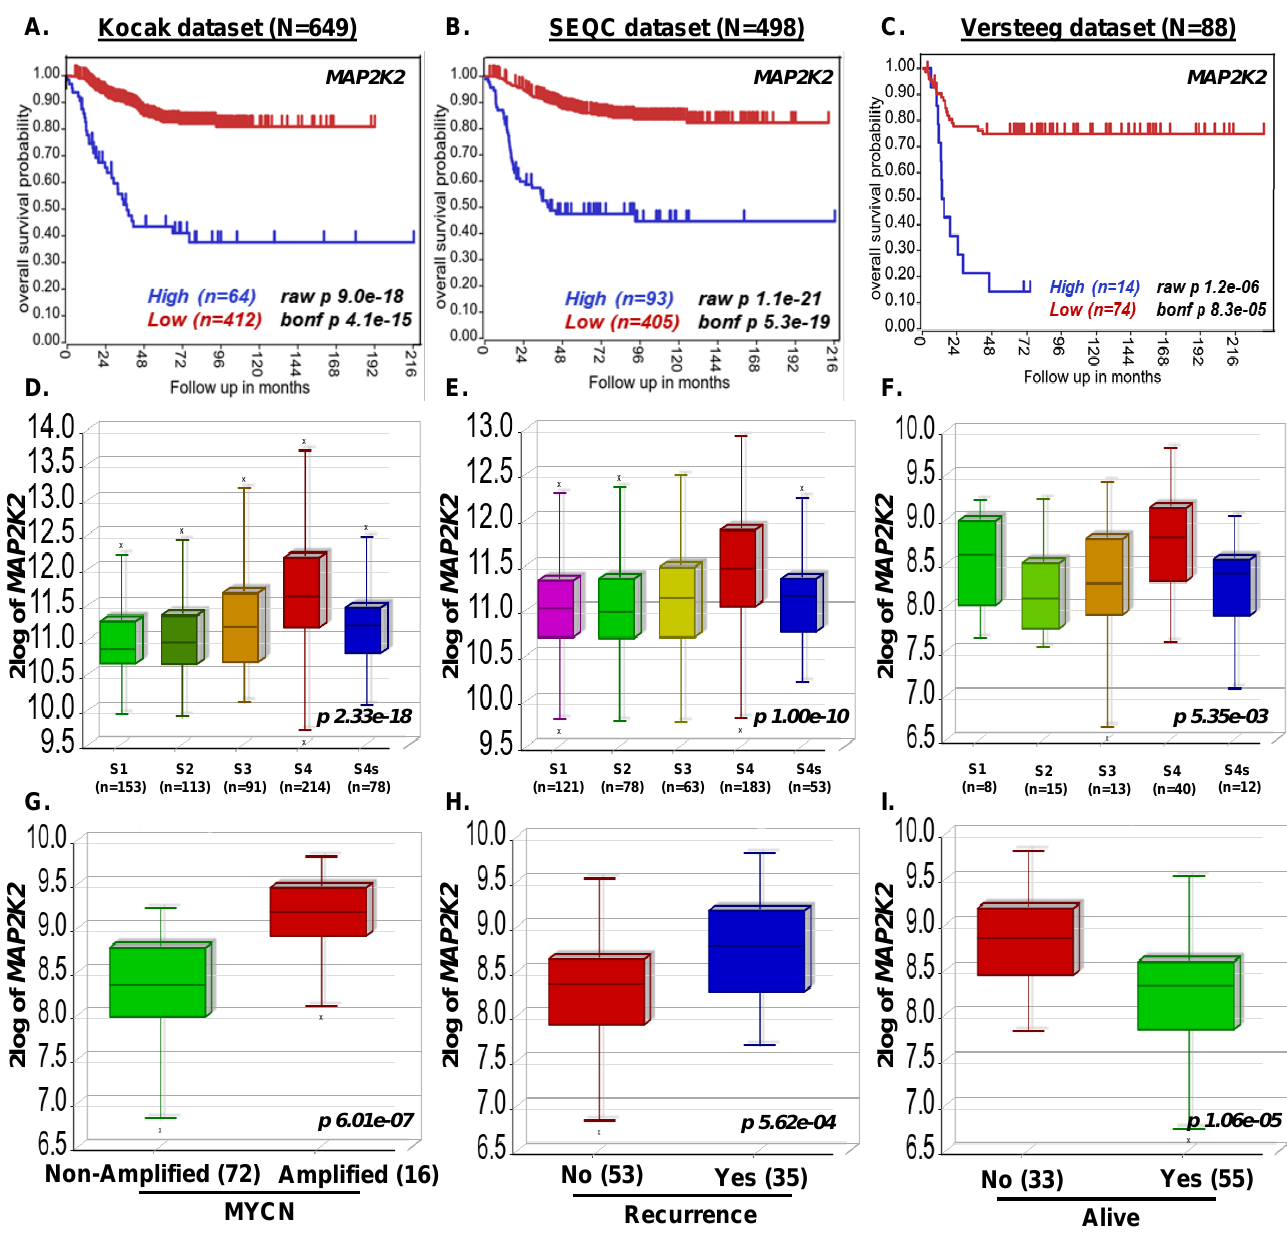
Figure 1. MAP2K2 expression correlates with poor overall survival of NB patients. ( A – C ) Kaplan- Meier survival analysis showing high expression of the MAP2K2 gene leads to the poor overall survival of NB patients in datasets analyzed. ( A ) Kocak dataset ( n = 649 patients). ( B ) SEQC dataset ( n = 498 patients). ( C ) Versteeg dataset ( n = 88 patients). ( D – F ) MAP2K2 expression correlates with NB stage progression in all datasets analyzed. ( D ) Kocak, ( E ) SEQC, ( F ) Versteeg. ( G – I ) Versteeg dataset analysis revealed that higher MAP2K2 expression correlates with ( G ) aggressive MYCN-amplified tumors, ( H ) disease relapse, and ( I ) worst overall